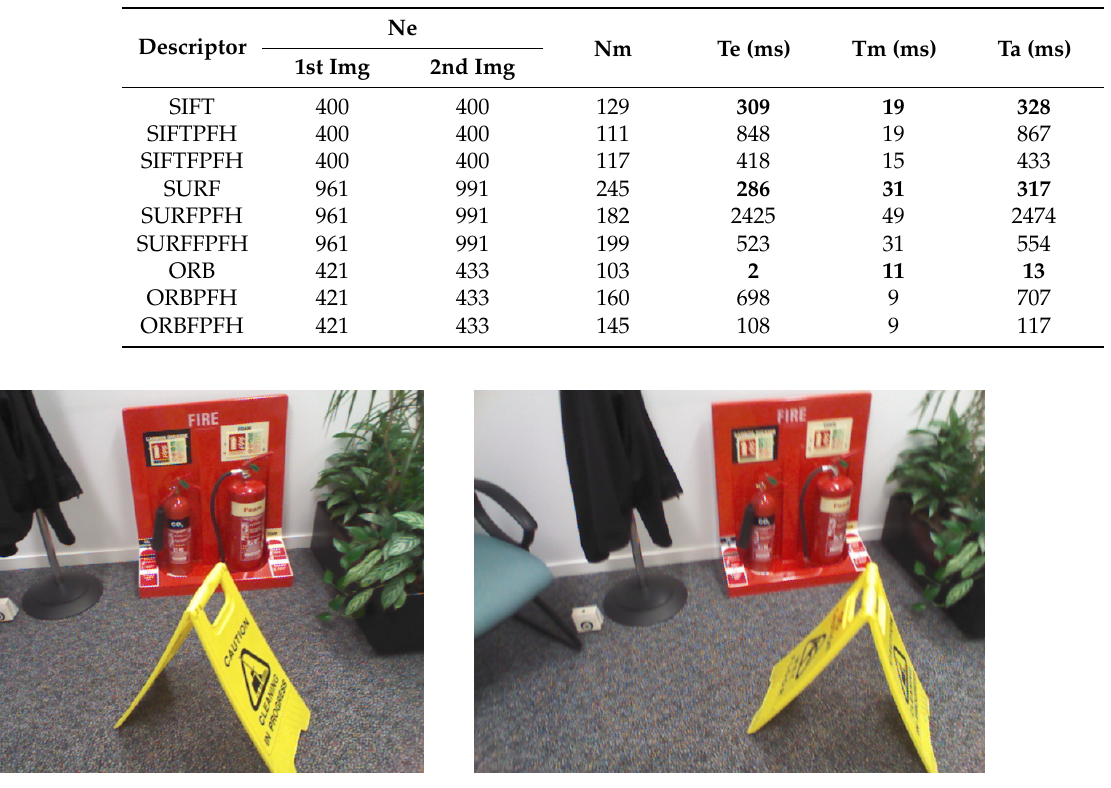
Figure 12. Test images in the YCB 0024 dataset. ( a ) 000001-color; ( b ) 000050-color. Table 1. Test results of the YCB 0024 dataset.